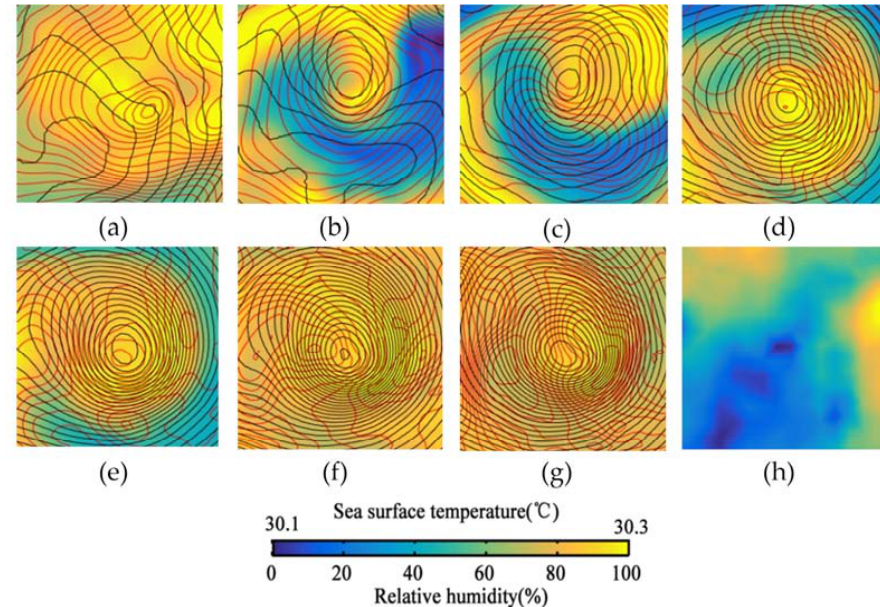
Figure 7. Images of atmospheric and oceanic variables at each level: ( a ) 100 hPa, ( b ) 200 hPa, ( c ) 300 hPa, ( d ) 500 hPa, ( e ) 700 hPa, ( f ) 850 hPa, ( g ) 1000 hPa, and ( h ) sea surface. In each image, red contours represent temperature (°C), black contours represent geopotential height (gpm), and colors represent relative humidity (%) in ( a – g ) and SST (°C) in (h). Table 2. Mean absolute errors (MAEs) (m/s) of the models trained on the three combinations of variables at different learning rates.